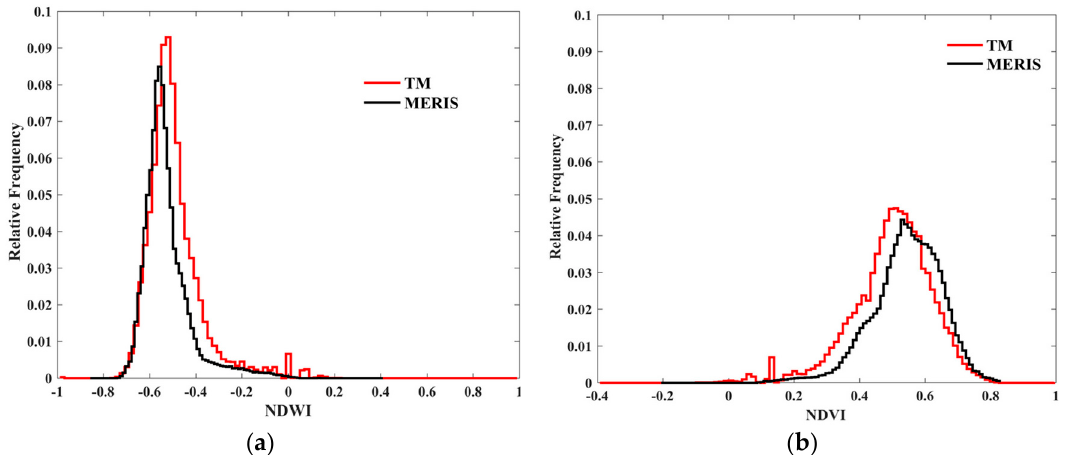
Figure 6. Histograms of ( a ) NDWI and ( b ) NDVI as generated from MERIS and TM images acquired on 17 April 2008.